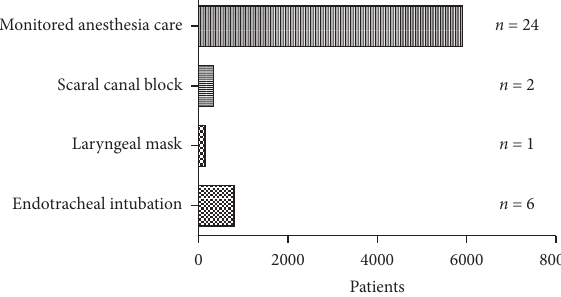
Figure 3: Anesthesia methods. n � number of